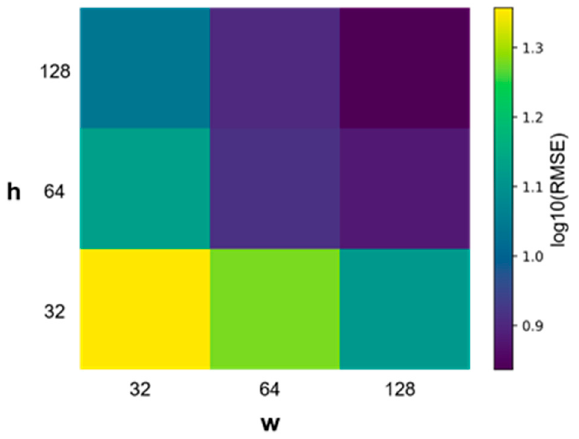
Figure 17. Performance under the different sizes of grids.